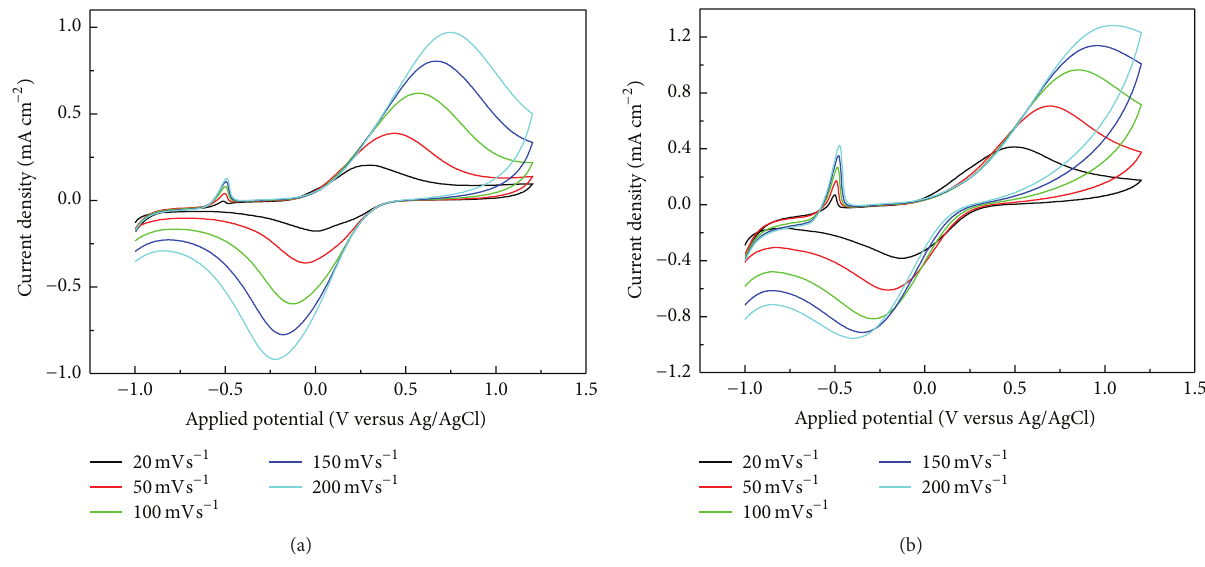
Figure 5: Voltammograms of (a) PPy-IC and (b) PPy-IC-Ag nanop in 0.1 molL −1 LiClO 4 solution at different scan rates.